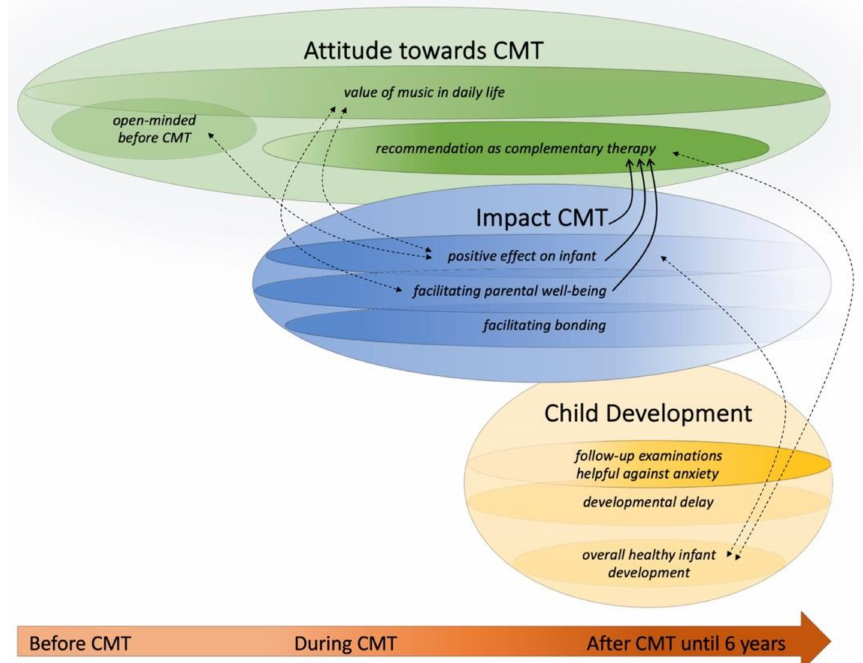
Figure 2. Final Thematic Map. Graphic Visualization of the Three Themes and the Nine